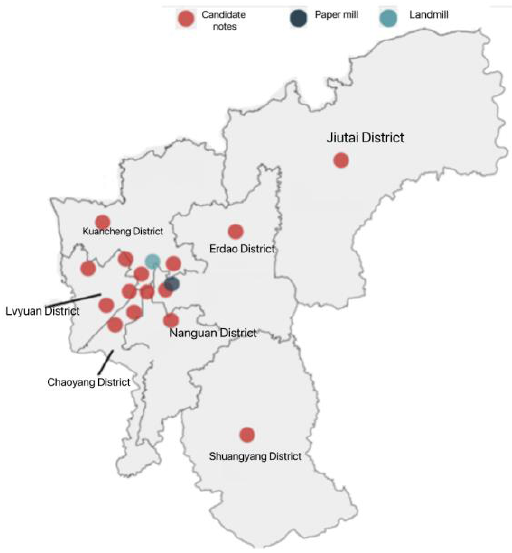
Table 4. Latitude and longitude of candidate nodes.